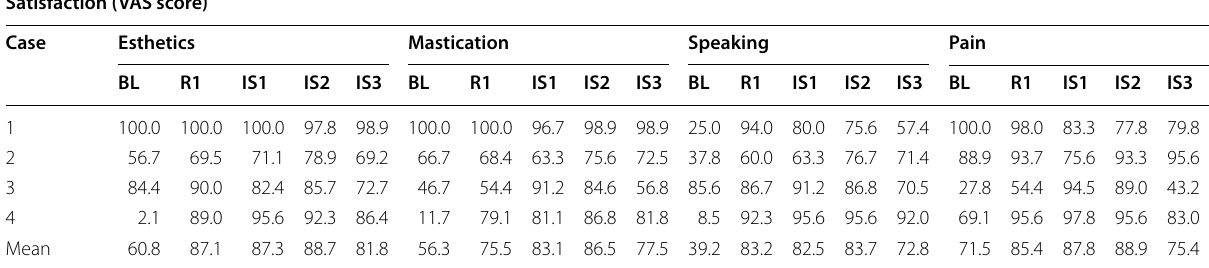
BL baseline, R1 3 months after insertion of removable partial denture (RPD), IS1 3 months after insertion of implant-supported RPD, IS2 6 months after insertion of implant-supported RPD, IS3 12 months after insertion of implant-supported RPD, VAS visual analog scale Table 8 Variation in patient satisfaction of each patient Satisfaction (VAS